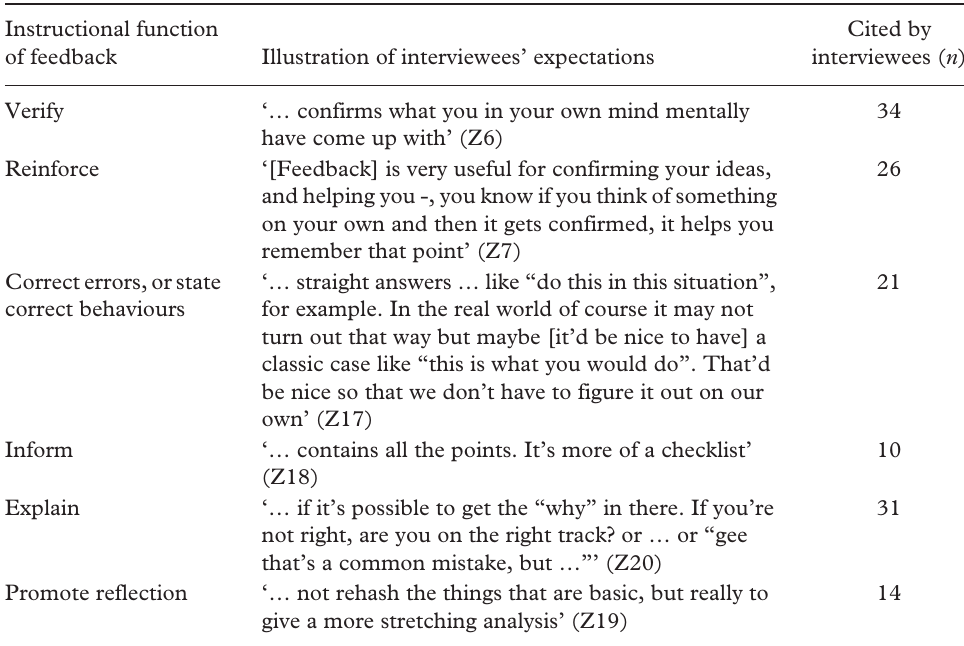
Table 3. Illustrations of interviewees’ expectations of ‘useful’ feedback Instructional